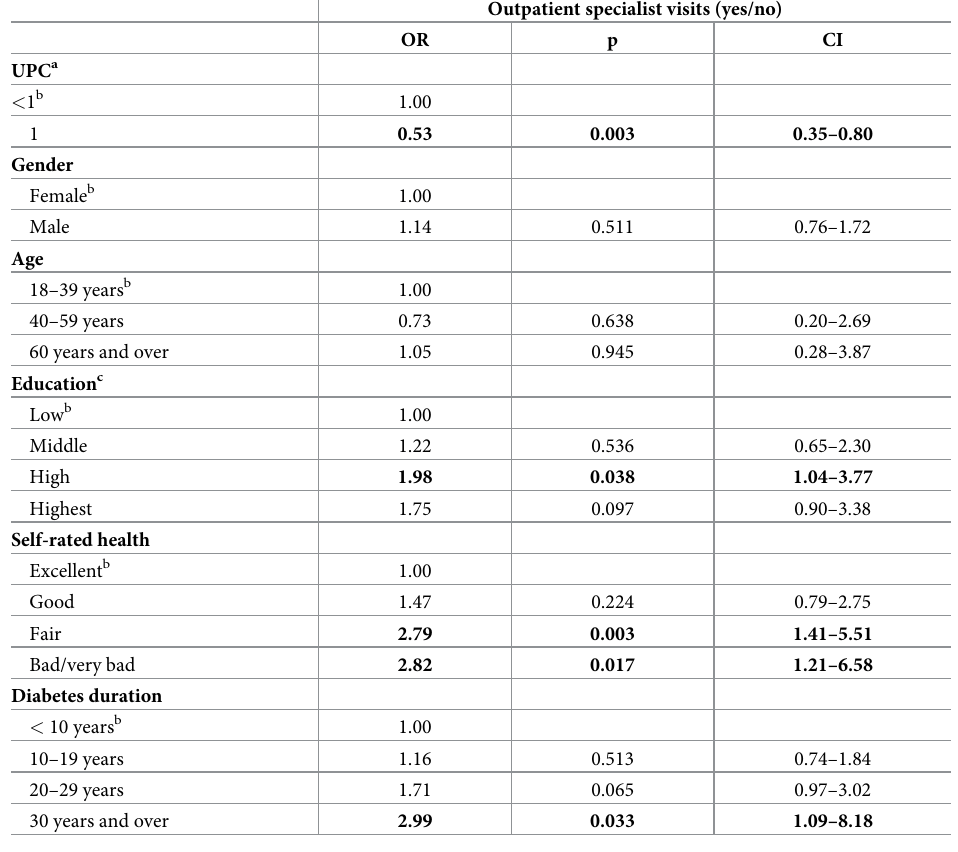
Table 2. Probability of one or more outpatient specialist visits according to Usual Provider Continuity (UPC) (N =